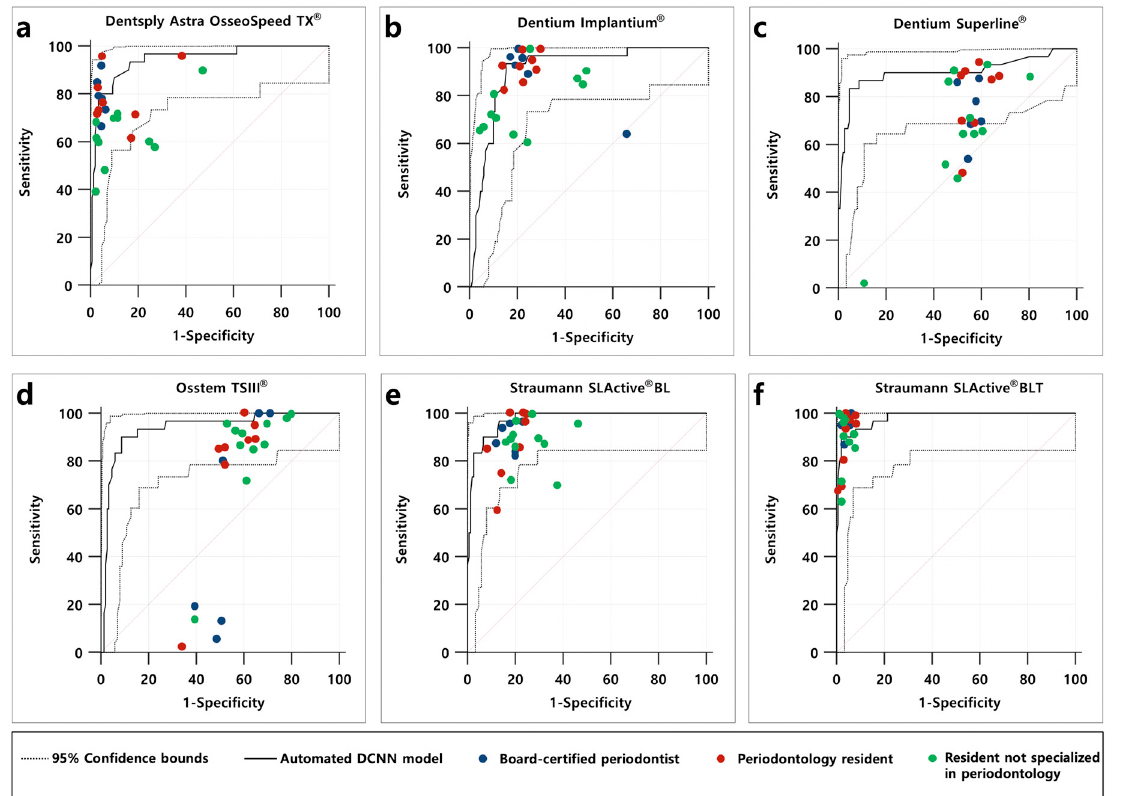
Figure 3. ( a – f ) Performance of the automated DCNN and comparison with dental professionals for classification of six types of DISs. Table 3. Accuracy comparison between the automated deep convolutional neural network and dental professionals for the classification of six types of DISs, based on 180 panoramic and periapical images randomly selected from the training dataset.